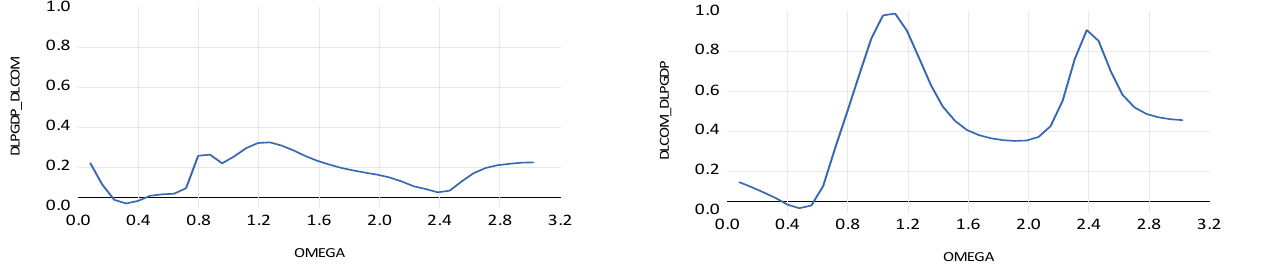
Figure 3: Causality from DLCOM → DLPGDP in the left and from DLPGDP → DLCOM in the right.